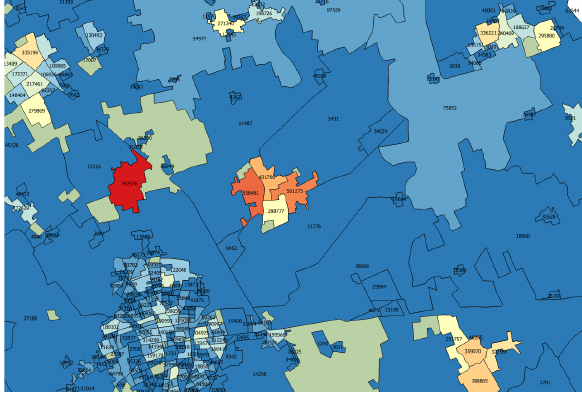
Figure 16. Excerpt from the map of the willingness to pay for home heating (€/year) (Magentino-Abbiatense